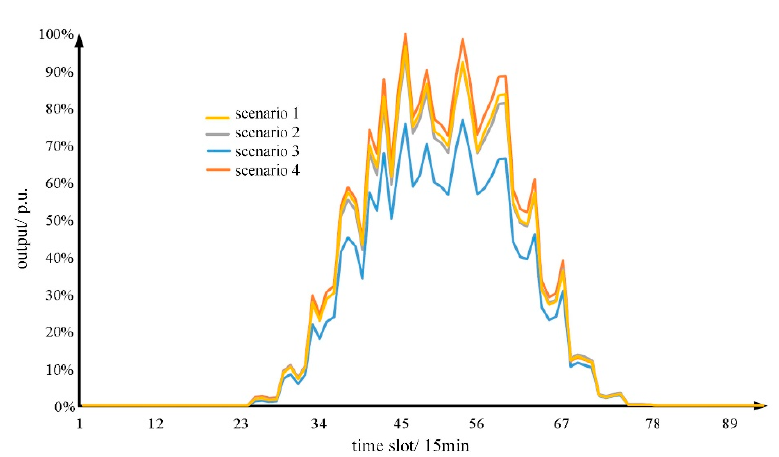
Figure 5. Typical scenarios of a wind farm.